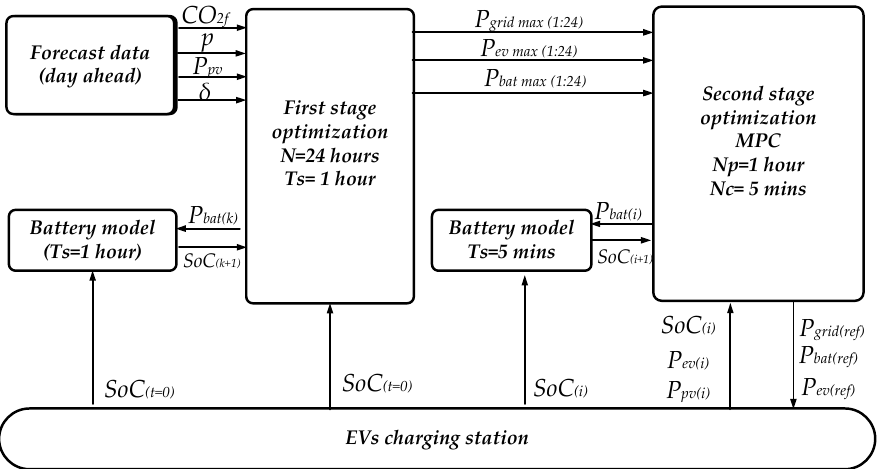
Figure 2. Proposed EMS considering a two-stage